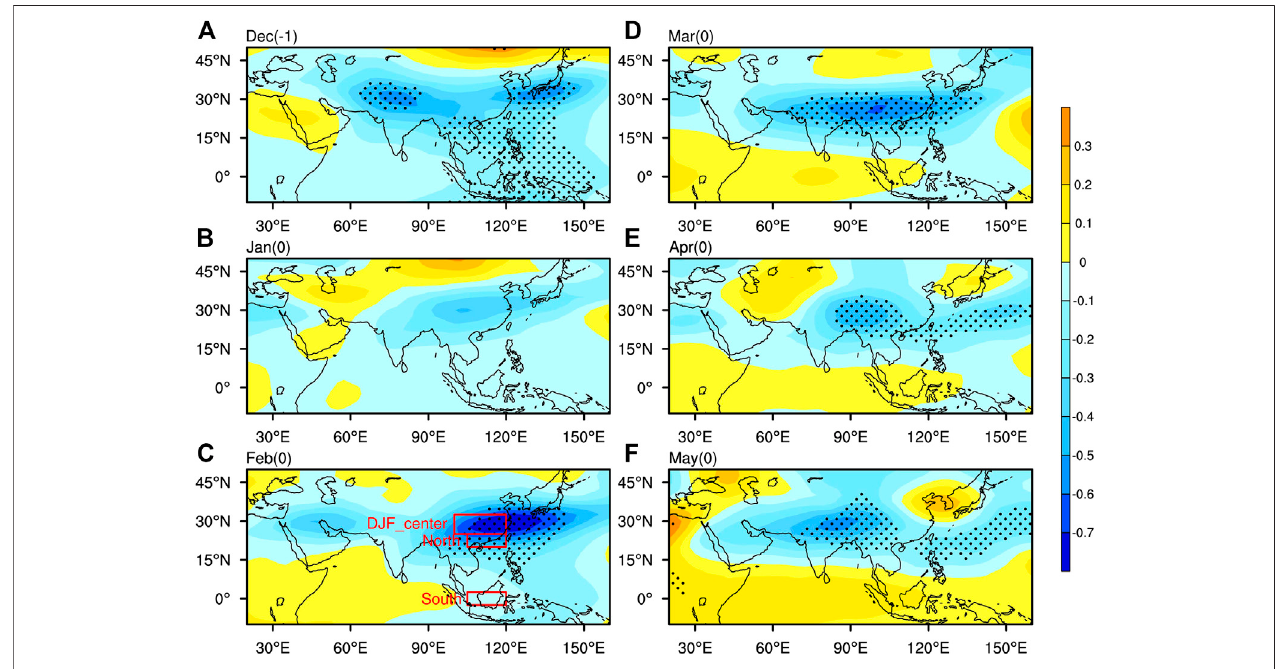
FIGURE 2 | Regressions of the monthly 500 – 200 hPa mean temperature against the SCSSM onset date from previous December to May. The regression coef fi cients signi fi cant at the 95% con fi dence level are stippled. The “ DJF_center ” is the demain (25 ° − 32.5 ° N, 100 ° − 120 ° E); “ North ” and “ South ” denote the northern domain (20 ° – 25 ° N, 105 ° – 120 ° E) and the southern domain (2.5 ° S – 2.5 ° N, 105 ° – 120 ° E) of the SCS,